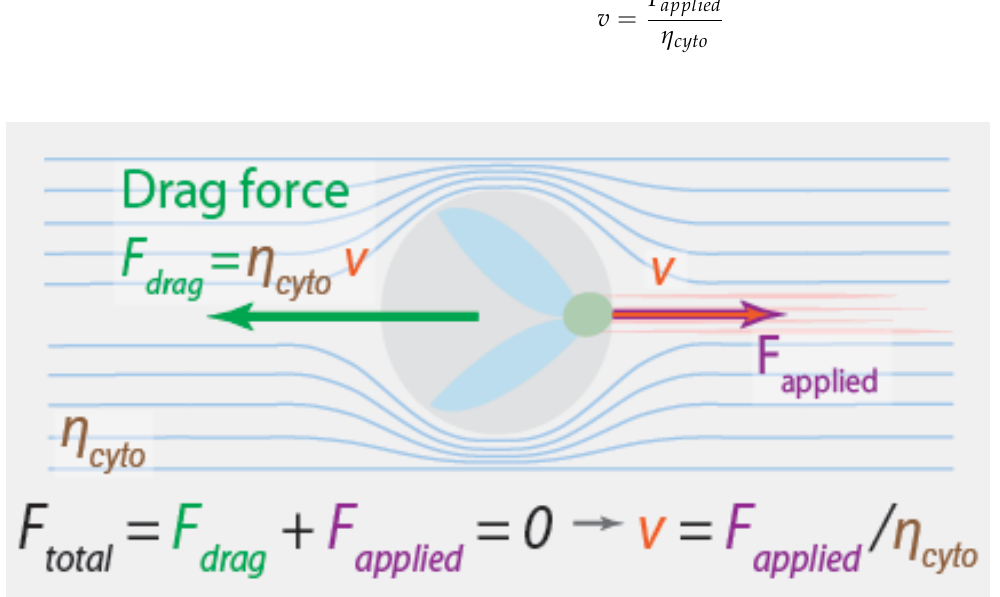
Figure 2. The motion of an isolated chromosome dragged by an optical tweezer. The velocity of the chromosome is determined by the balance of the applied force from the optical tweezer, F applied , and the fluid drag force, F drag = − η cyto v .